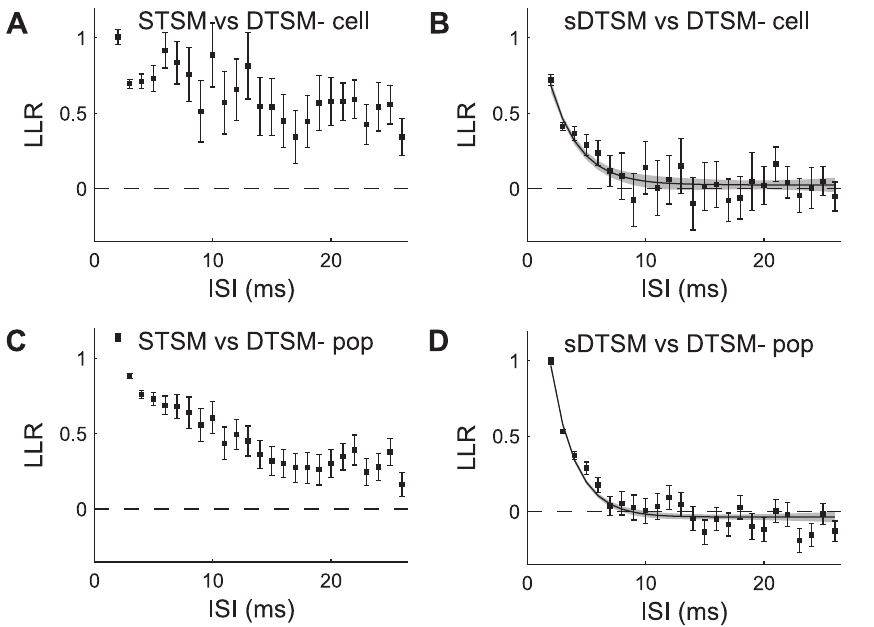
Figure 7. Likelihood analysis. A: Distribution of mean log-likelihood ratios for data-based doublet and singlet models for ISIs ranging from 2–25 ms, from the same cell as in Figure 6. Error bars show 6 95% confidence intervals on the mean. B: Distribution of log-likelihood ratios for data- based and synthetic doublet models for same cell as in panel A. Solid black curve shows double exponential model (Eq. 9) fit to data, gray shading indicates 95% confidence interval on predictions from model. C: Distribution of log-likelihood ratios for data-based doublet and singlet models, data pooled across 8 cells, presentation as in A. D: Distribution of log-likelihood ratios for data-based and synthetic models, pooled across 8 cells, as well as exponential model fit to data. Presentation as in panel B.